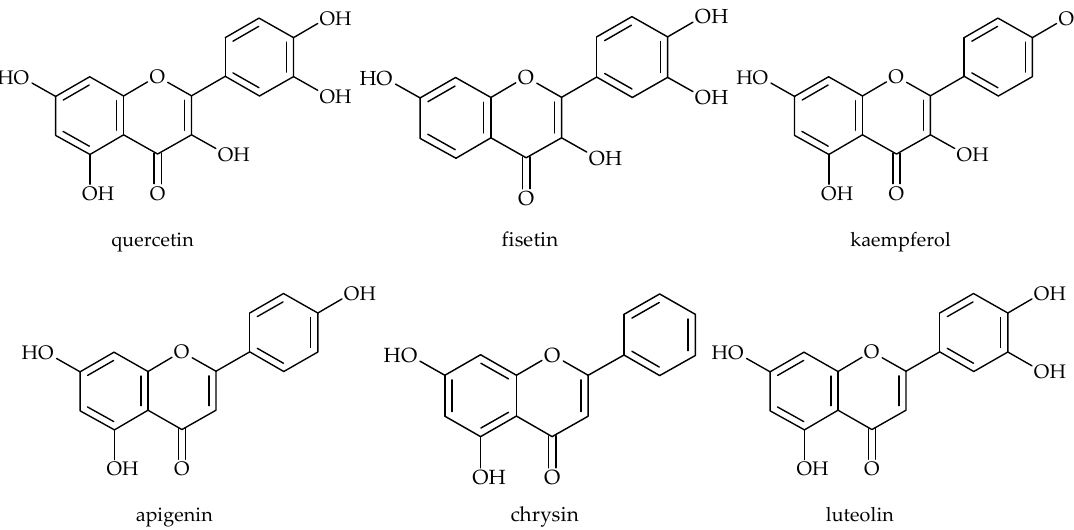
Figure 6. Chemical structures of red wine components: quercetin, fisetin, kaempeferol, apigenin, chrysin and luteolin.